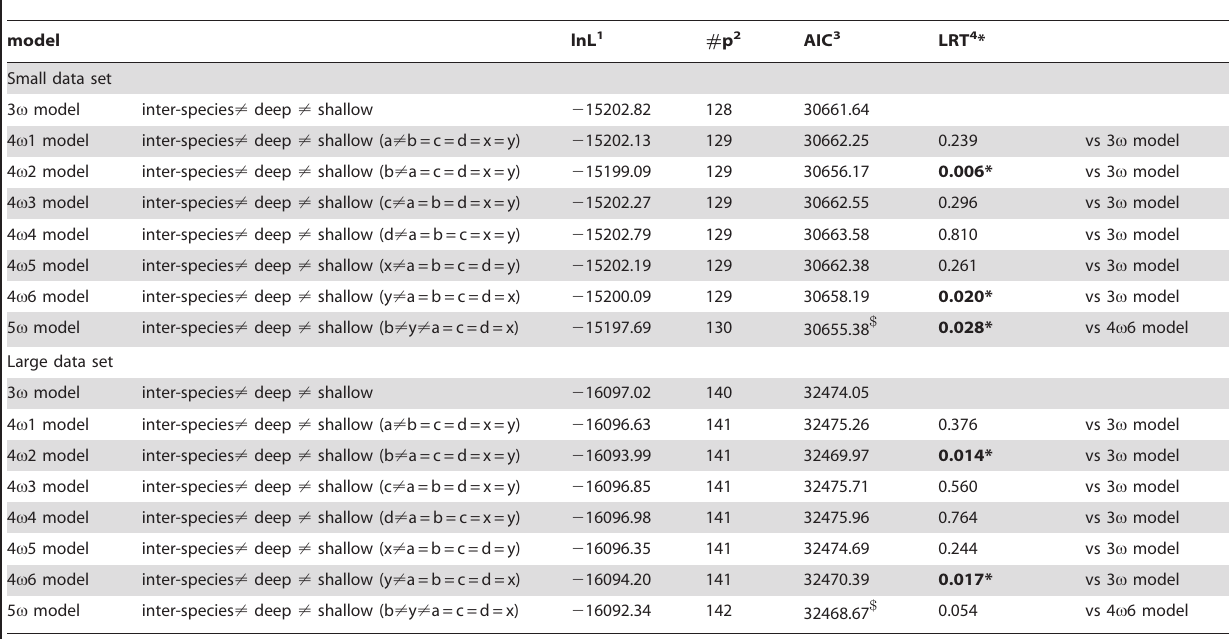
Table 4. The model comparisons for the different v ratios in the deep branches.